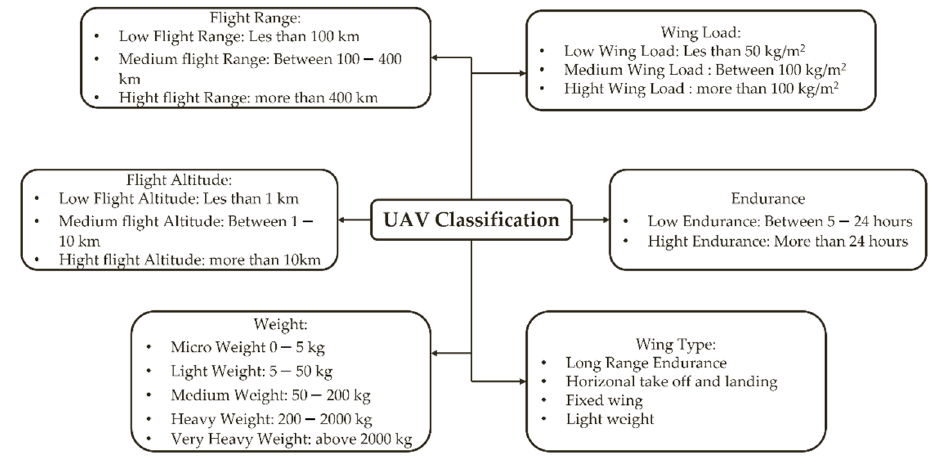
Figure 3. UAV classification.